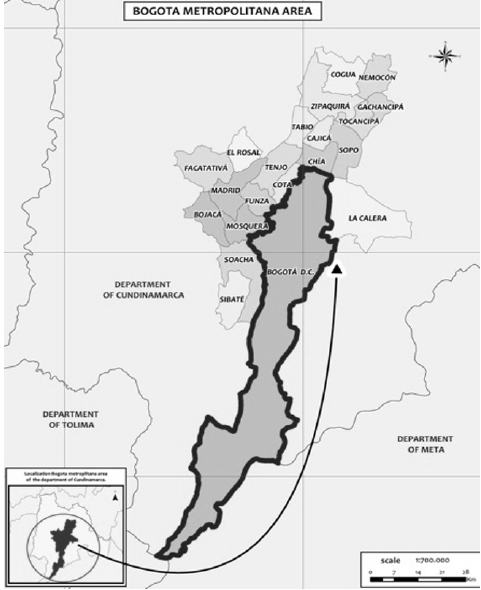
Figure 7: Metropolitan area of Bogota according to DANE (2005